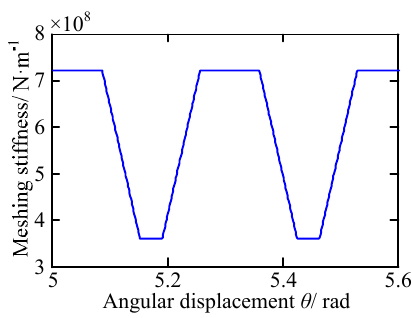
Figure 4. Meshing stiffness. M pg , C pg and K pg are the mass, damping and stiffness matrices of the gear pair, respectively. X pg and V pg are the displacement vector and meshing matrix of the gear pair. F pg is the exciting force vector, which is a non-constant vector and is related to the time-varying variables k m , c m and e m .